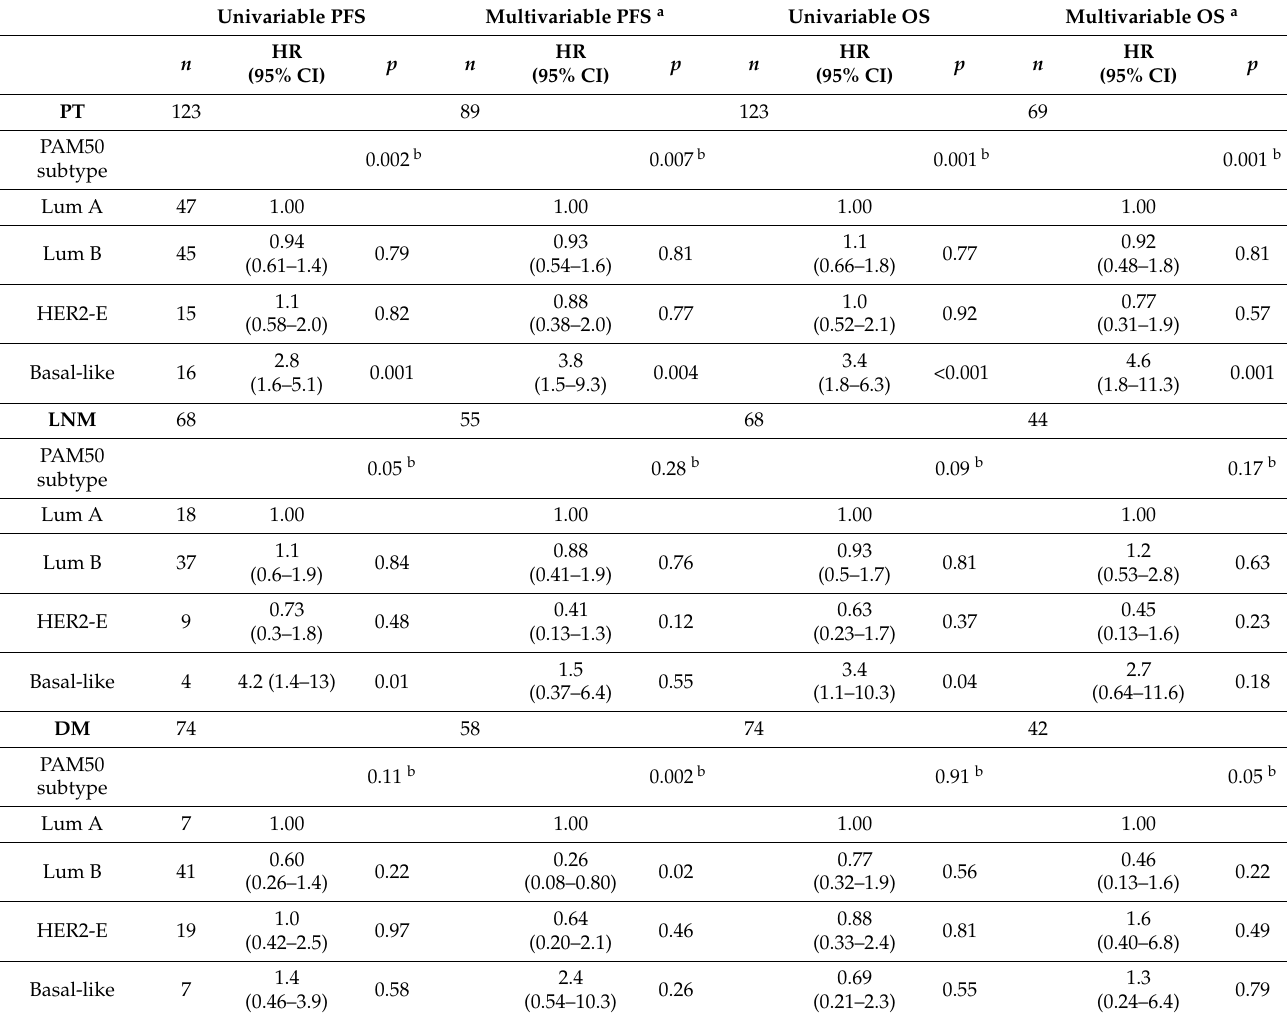
Table 2. Univariable and multivariable Cox regression models of PAM50 breast cancer intrinsic subtypes in primary tumors, lymph node metastases, and distant